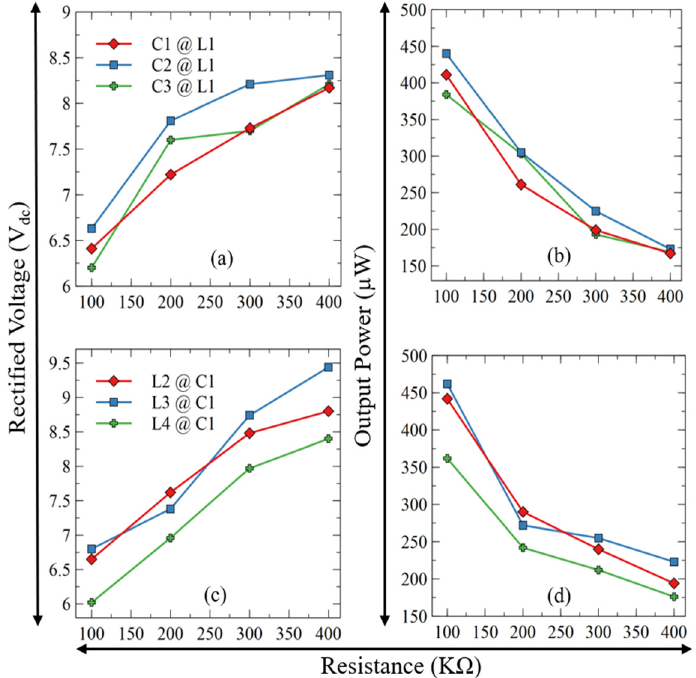
Figure 15. Outputs at different resistances of the proposed circuit with input voltage of 0.4 V i ( a , c ) Rectified voltage, and ( b , d ) Output power.